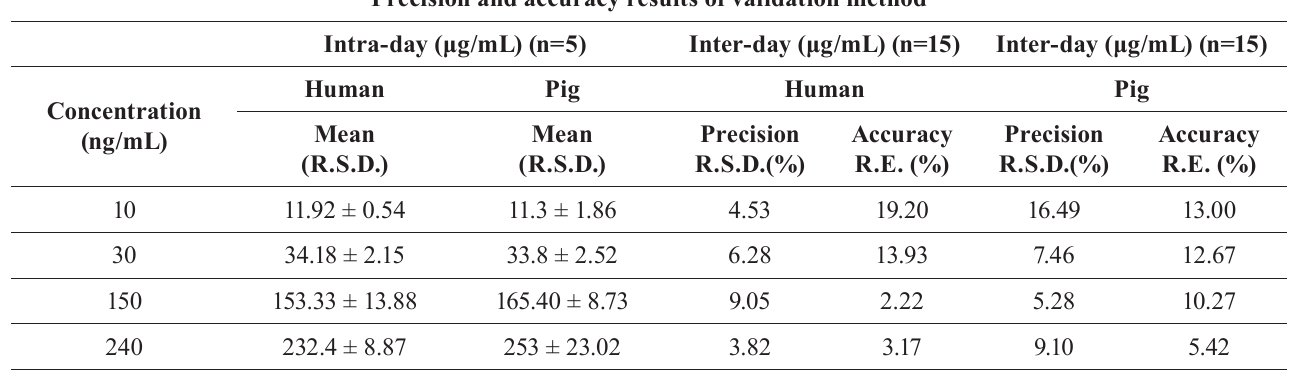
TABLE I - A ccuracy results for human and pig tape Precision and accuracy results of validation method